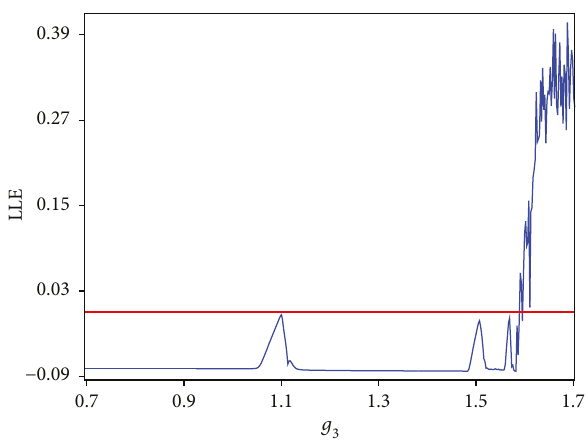
Figure 11: Bifurcation diagram of k 1 73 .